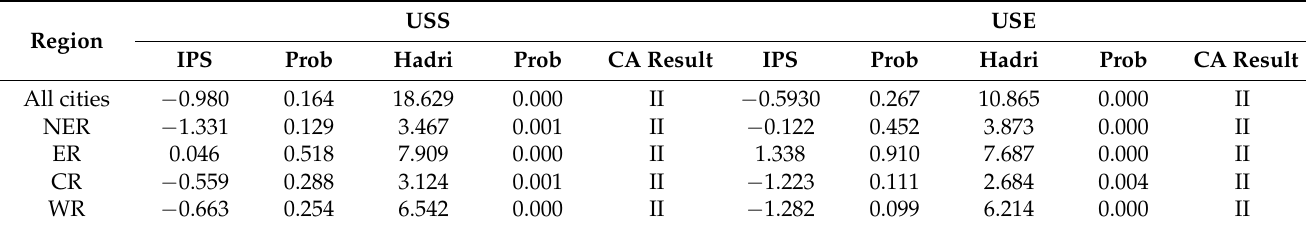
Table 3. Global convergence test